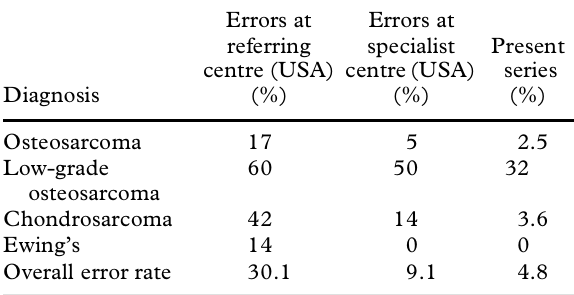
Table 2. Table to show comparative data for underdiagnosed malignant bone tumours between non-specialist and specialist centres in the USA and the present investigation: USA figures based on those in Mankin et al. 3 Errors Diagnosis